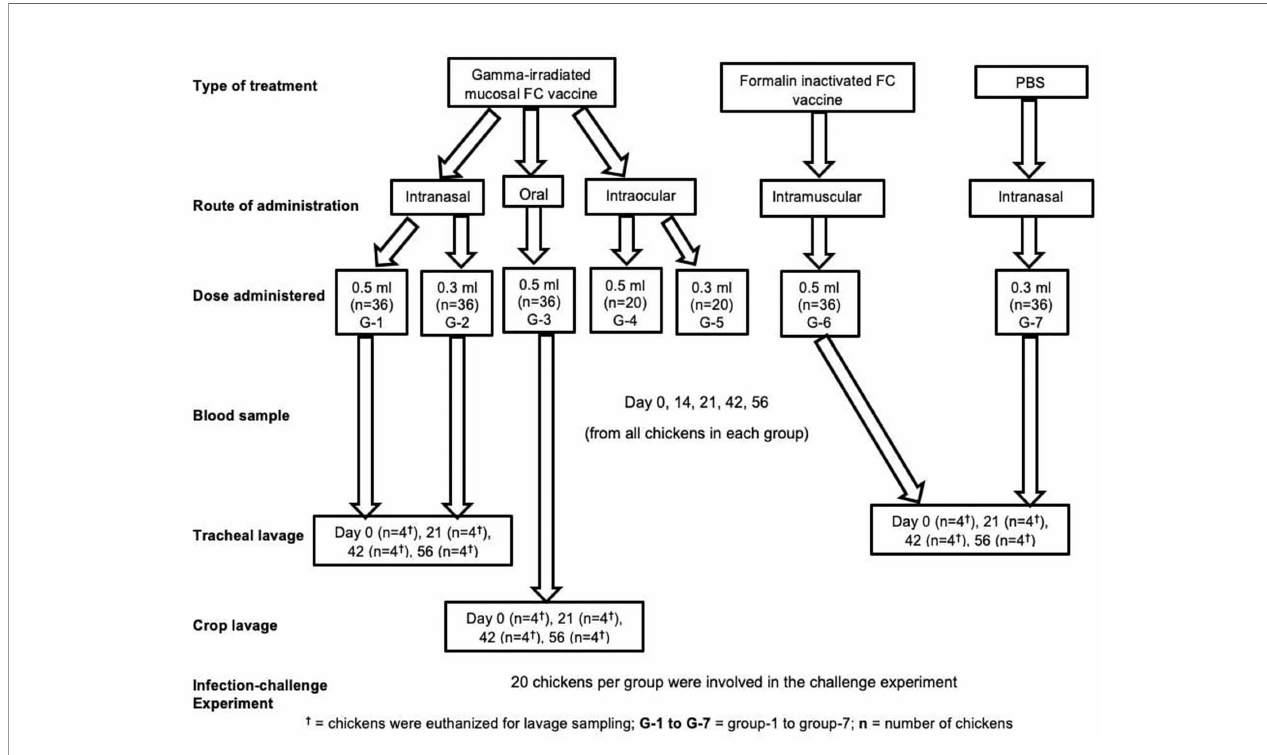
FIGURE 1 | Experimental design groups; treatment, comparator, and control, route of vaccine administration, and number of chickens in each group, number of chickens used in sampling, and number of chickens used in ef fi cacy